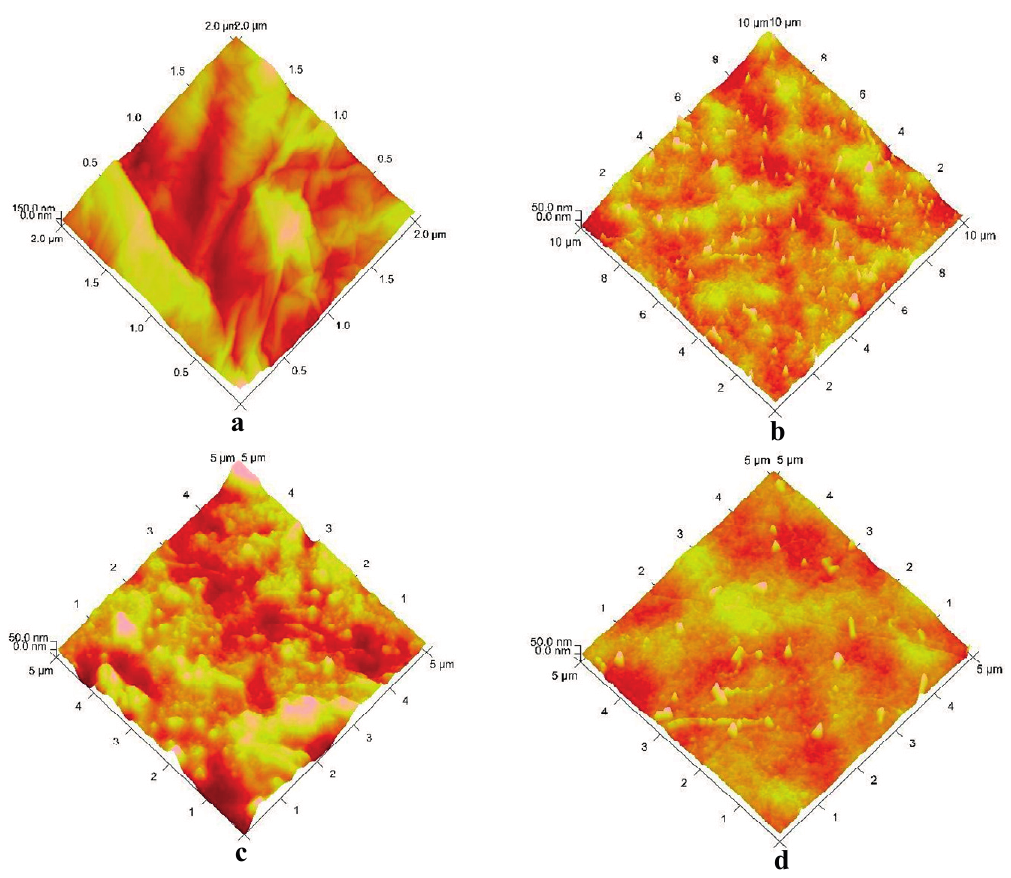
Figure 2. Atomic force microscopy (AFM) 3D images of ( a ) ELO plasticized PLA; ( b – d ) 2, 3 and 5 wt. % MWCNTs-reinforced PLA/ELO